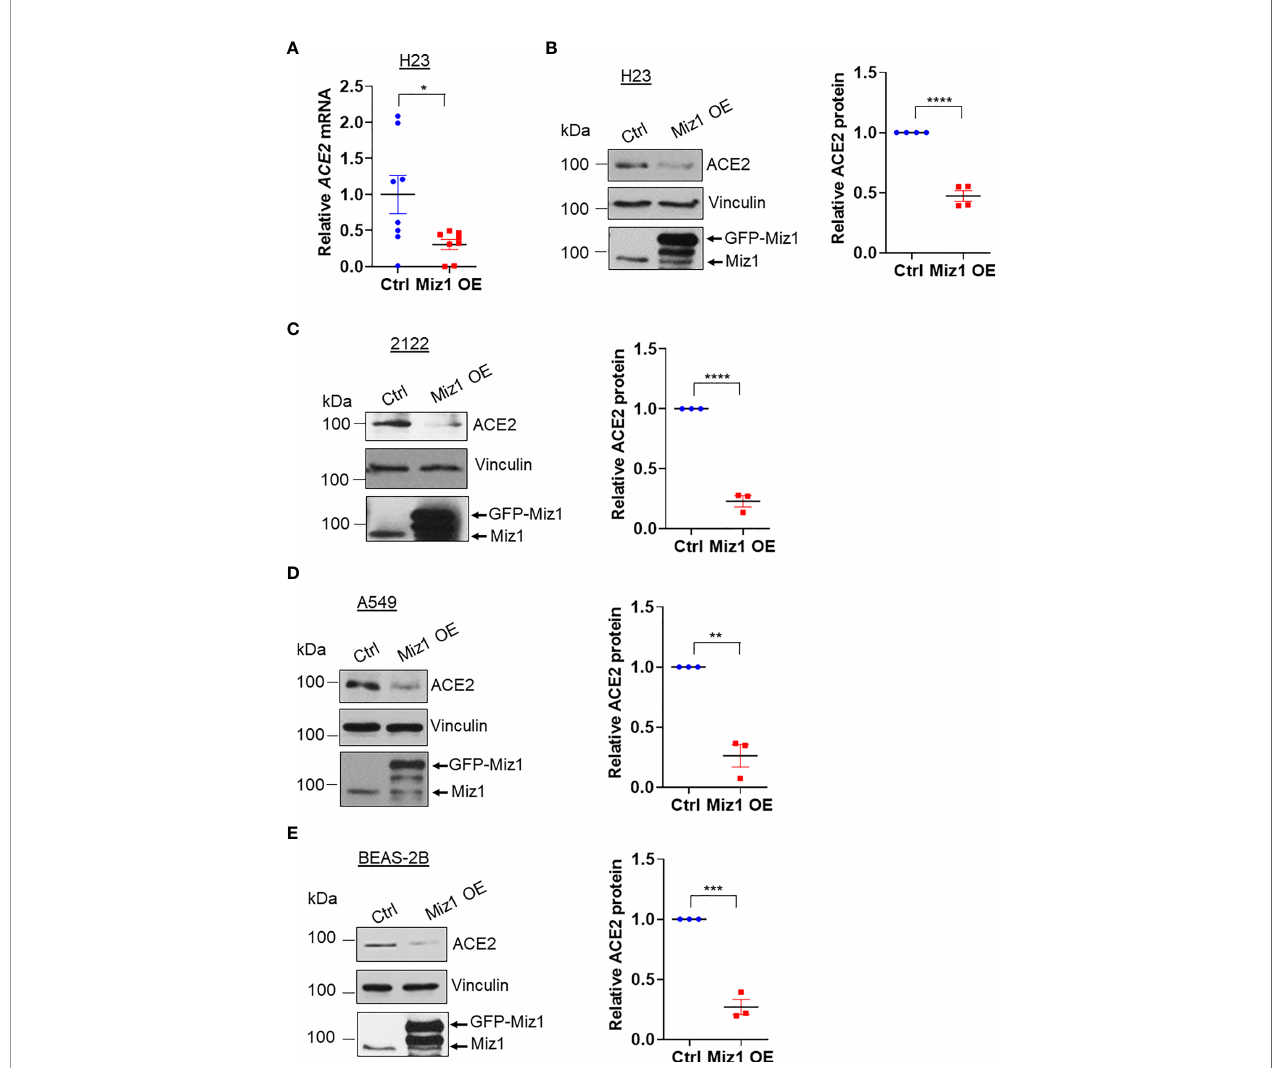
FIGURE 6 | Knockdown of MIZ1 reduces ACE2 expression in human lung epithelial cells. (A) ACE2 mRNA in H23 cells stably expressing GFP-tagged human MIZ1 protein. (B – E) ACE2 protein expression in H23 (B) , 2122 (C) , A549 (D) , and BEAS-2B cells (E) stably expressing GFP-tagged human MIZ1 protein. Data are presented as means ± sem from three to four independent experiments. * p < 0.05, ** p < 0.01, *** p < 0.001 and **** p <